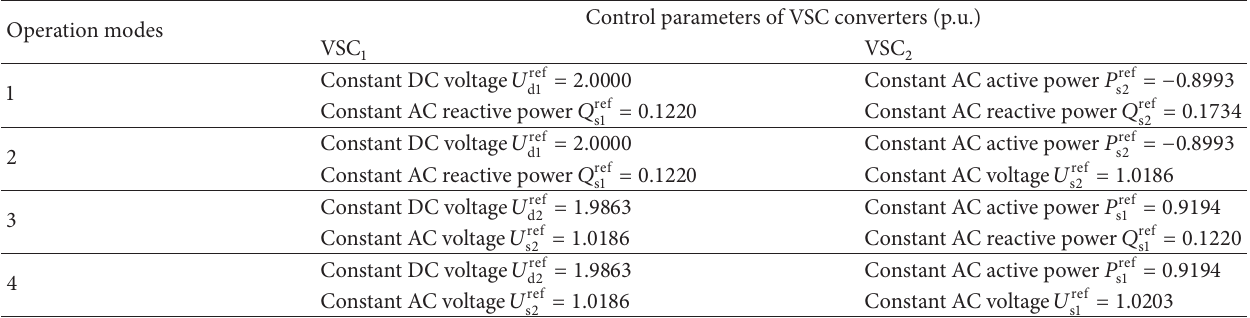
Table 1: System parameters of operation and control modes of VSC-HVDC.